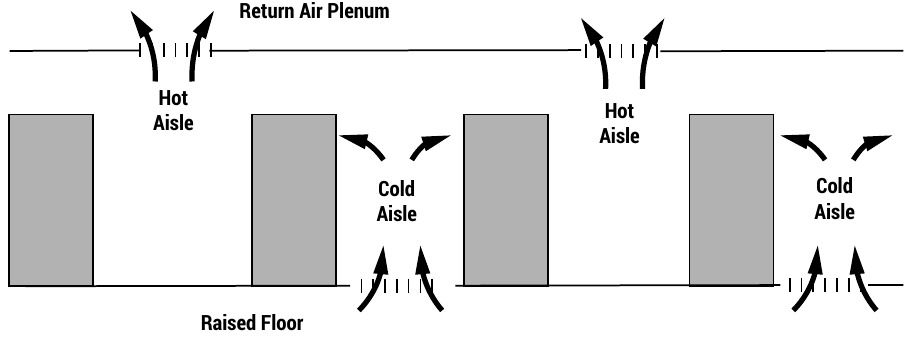
Figure 1. Typical data center hot/cold aisles